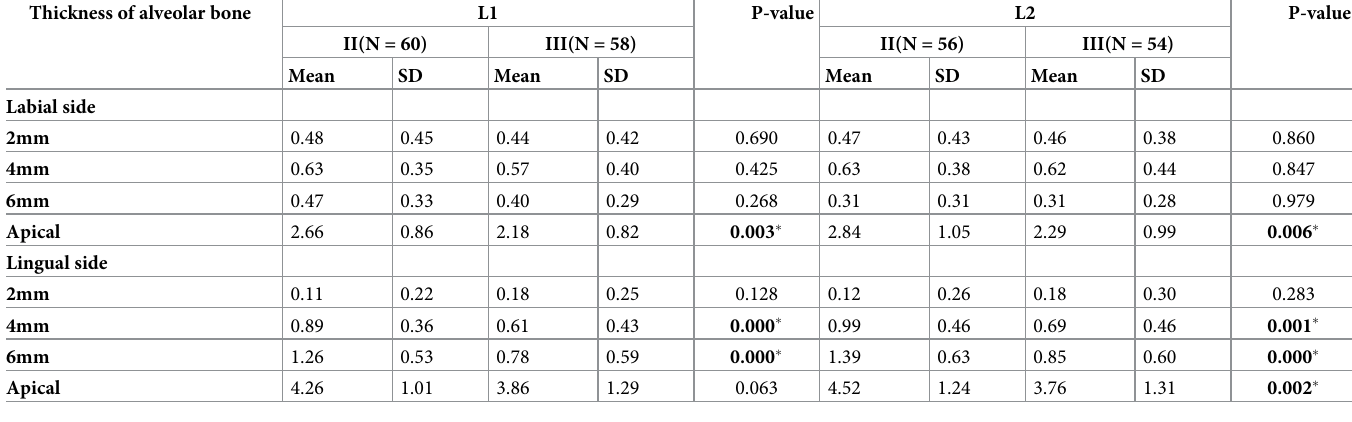
Table 8. Comparison of the thickness of mandibular alveolar bone between skeletal Class II malocclusion patients and skeletal Class III malocclusion patients (mm). Thickness of alveolar bone L1 P-value